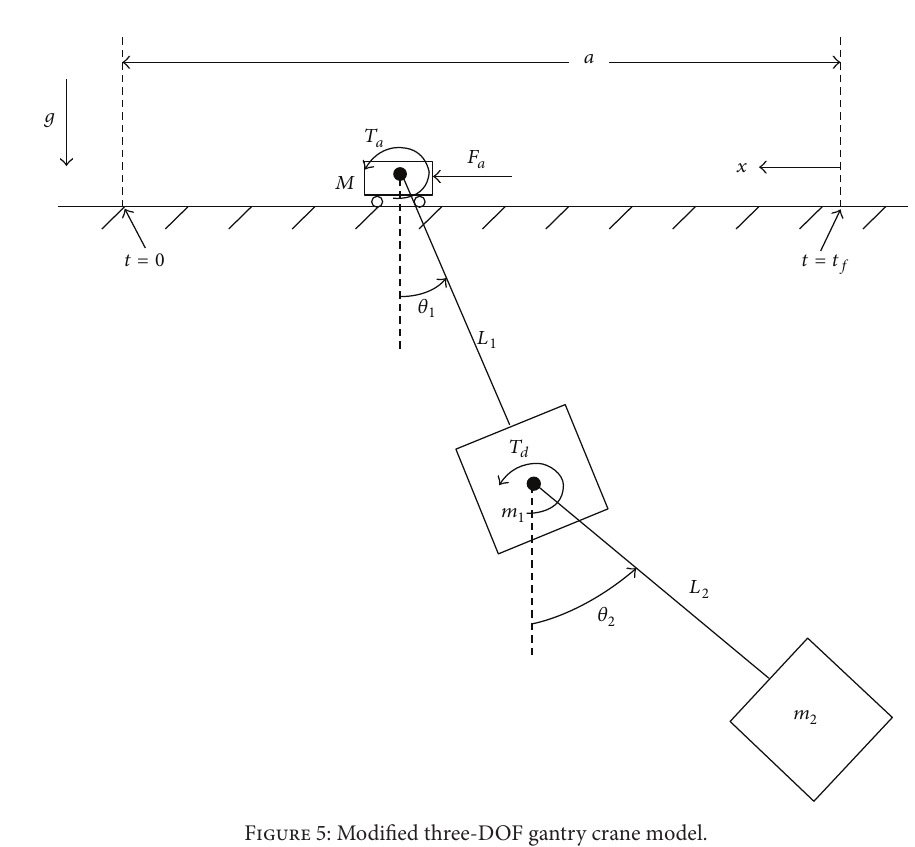
Figure 4: Histograms of (a) cart trajectory and (b) forces for the fully actuated gantry crane.